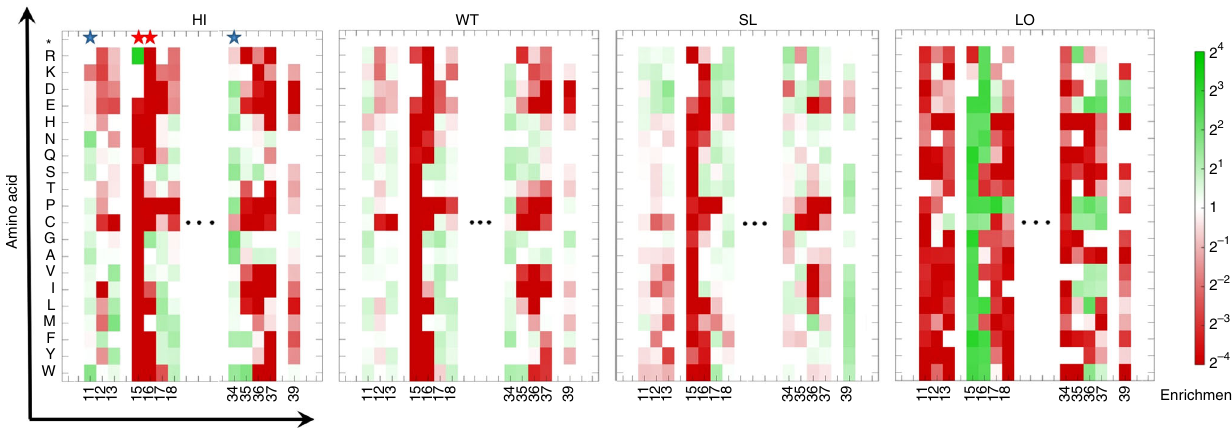
Fig. 2 Enrichment values for the BT/BPTI complex. The heat map shows enrichment of each BPTI variant in each of the four af fi nity groups relative to the naive library as calculated by Eq. (3). The enrichment value varies from high (green) to red (low). Red and blue starts indicate binding hot-spots and tolerant positions, respectively. Source data are provided as a Source Data fi